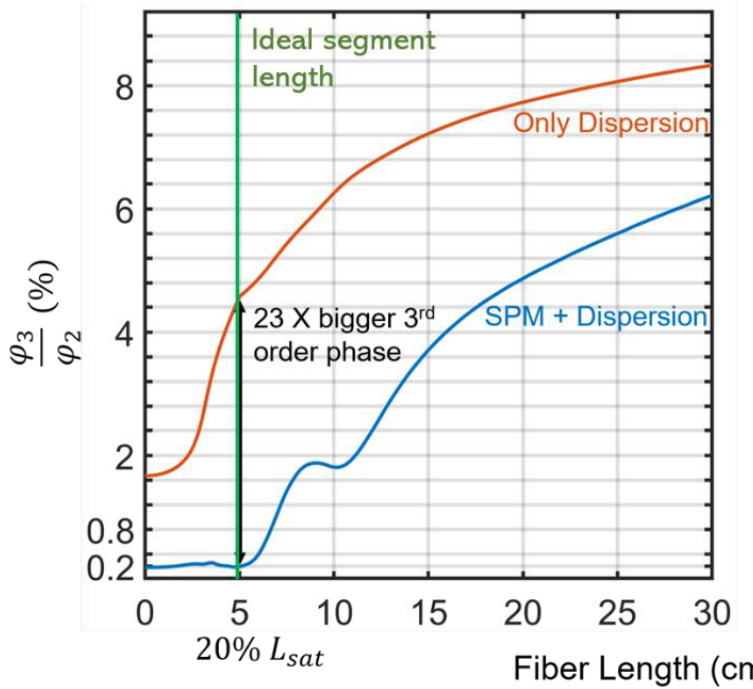
Figure 5. Plot of the percentage of third-order spectral phase contribution to second-order contribution at the 1/e bandwidth of the supercontinuum pulse versus propagation distance in fiber. Results are obtained from the GNLSE simulation. Red (top curve) corresponds to the case where only dispersion is present, blue (lower curve) corresponds to the case with both SPM and dispersion. The lower curve of Figure 5 corresponds to the percentage of third-order spectral phase contribution to second-order at the 1/e bandwidth of the pulse (i.e., 100% × with SPM and dispersion, while the top curve corresponds to only when dispersion is (cid:12) (cid:12) d 3 (cid:12) (cid:12) ∆ ν present (i.e., 100% × (cid:12) (cid:12) 6 d 2